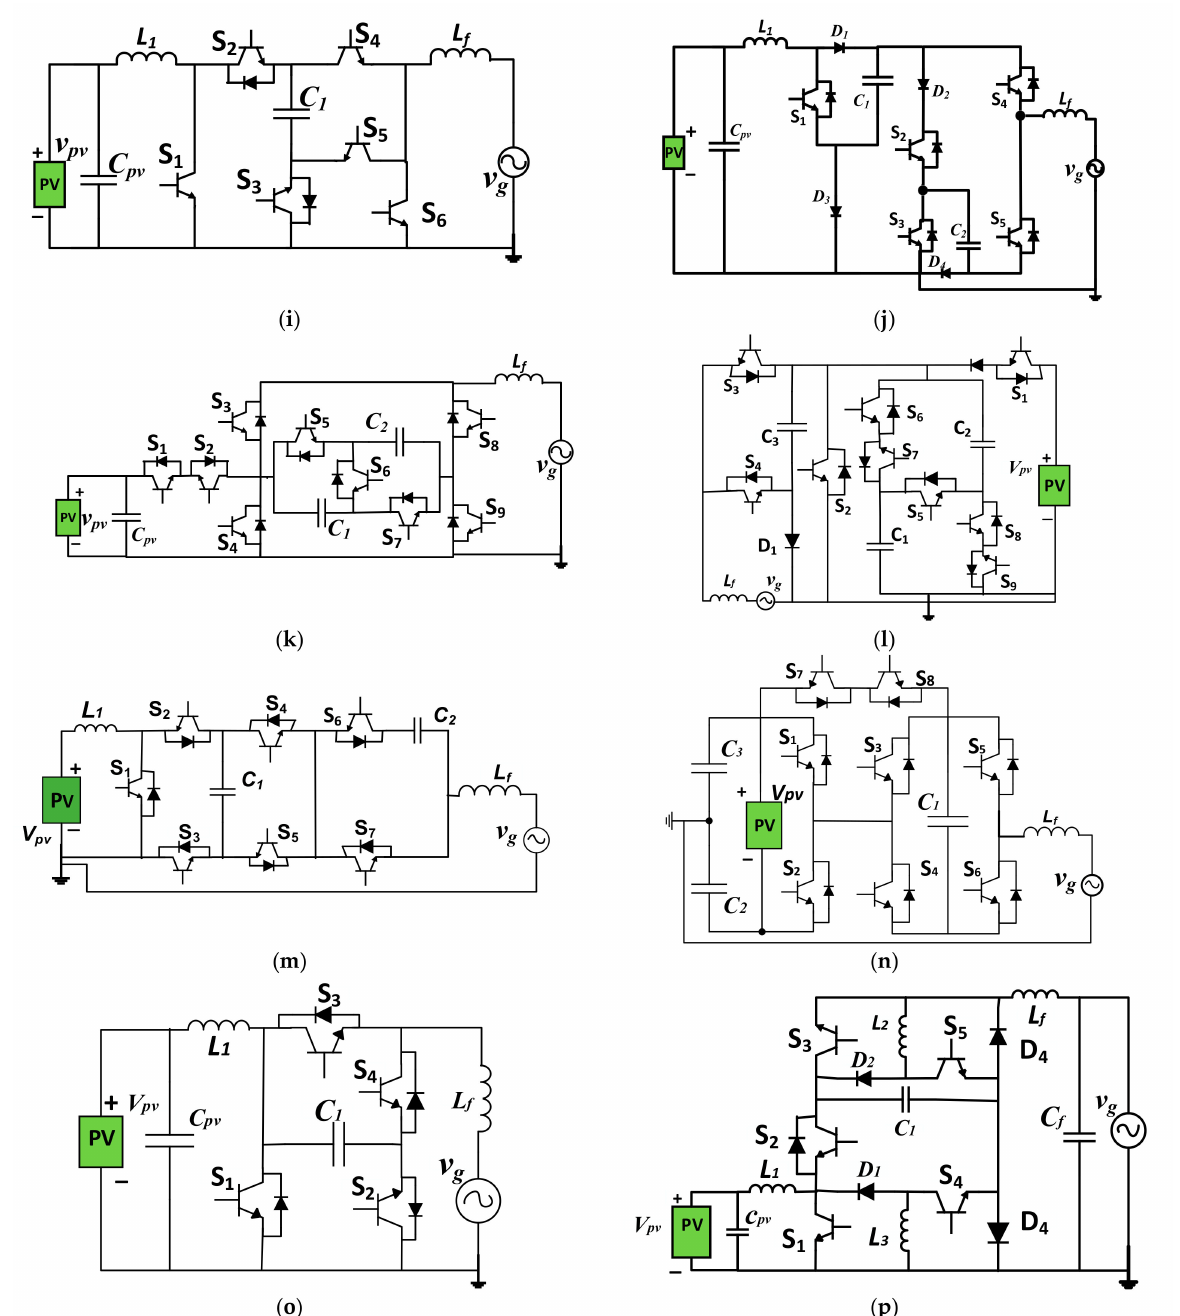
Figure 6. Voltage-source common-ground (CSCG) converters (buck/boost type). ( a ) Converter presented in the work of [64], ( b ) converter presented in the work of [65], ( c ) converter presented in the work of [66], ( d ) converter presented in the work of [67,68], ( e ) converter presented in the work of [69], ( f ) converter presented in the work of [70,71], ( g ) converter presented in the work of [72], ( h ) converter presented in the work of [73], ( i ) converter presented in the work of [74], ( j ) converter presented in the work of [75], ( k ) converter presented in the work of [76–78], ( l ) converter presented in the work of [79], ( m ) converter presented in the work of [80], ( n ) converter presented in the work of [81], ( o ) converter presented in the work of [82], ( p ) converter presented in the work of